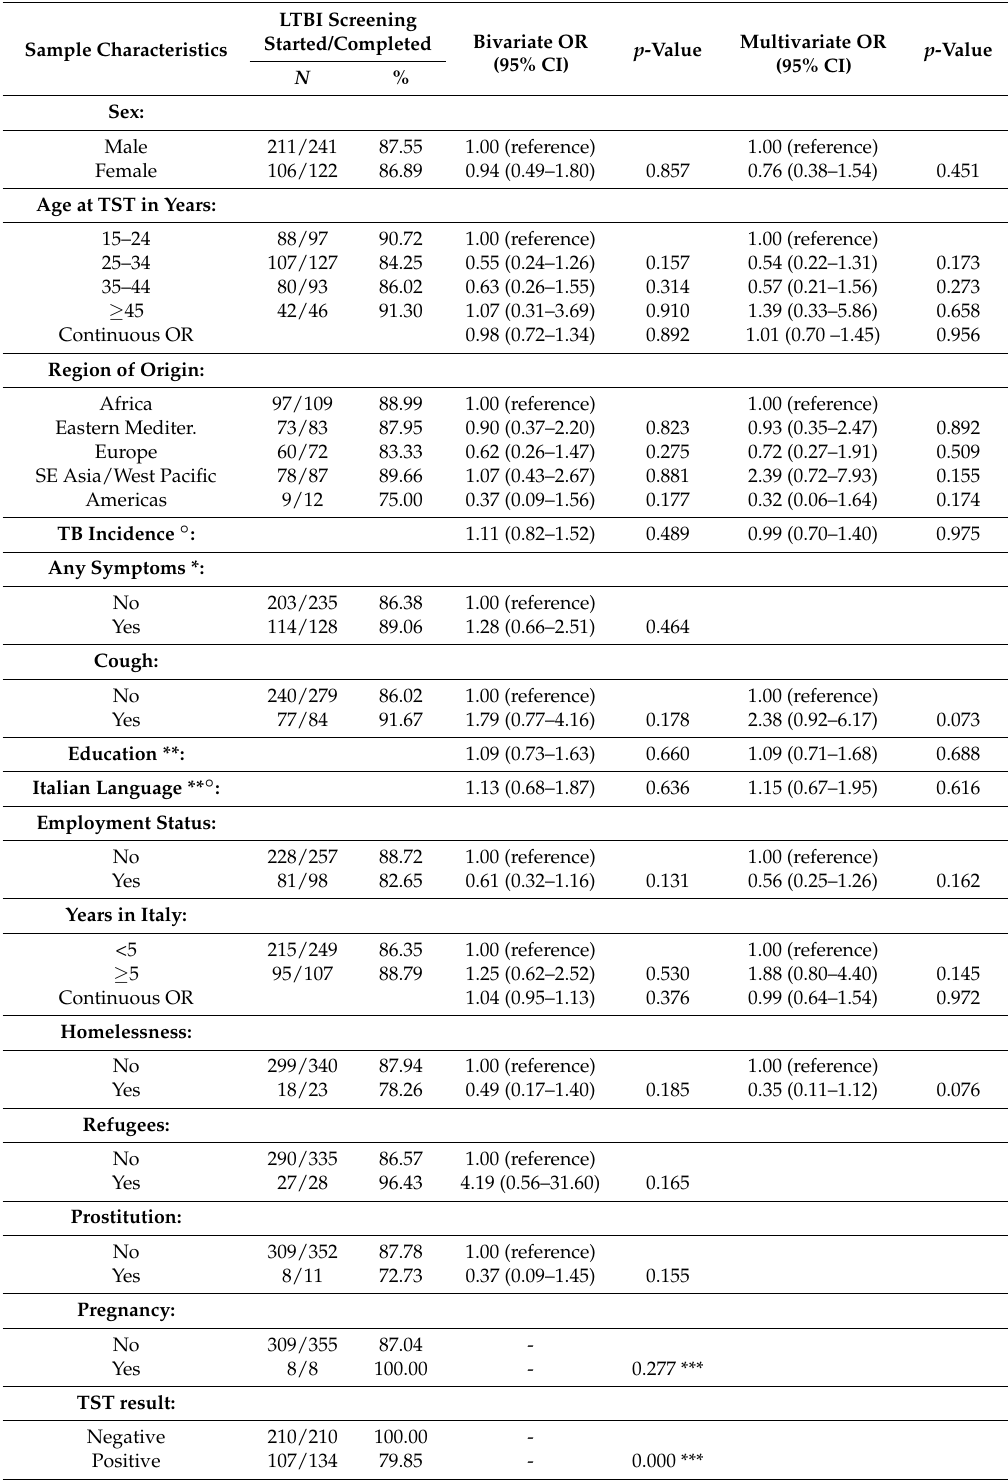
Table 3. Association between selected characteristics and compliance with screening for latent TB infection